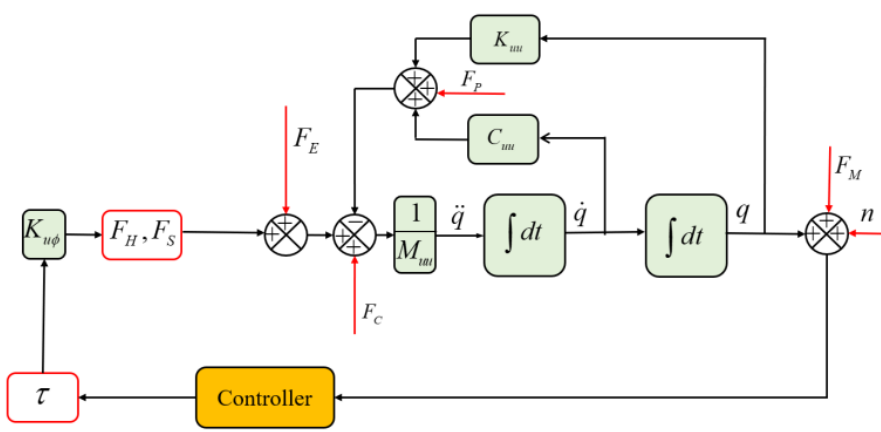
Figure 1. Distribution of disturbance/uncertainty in piezoelectric smart structures. Table 1. Disturbances/Uncertainties in smart structures.